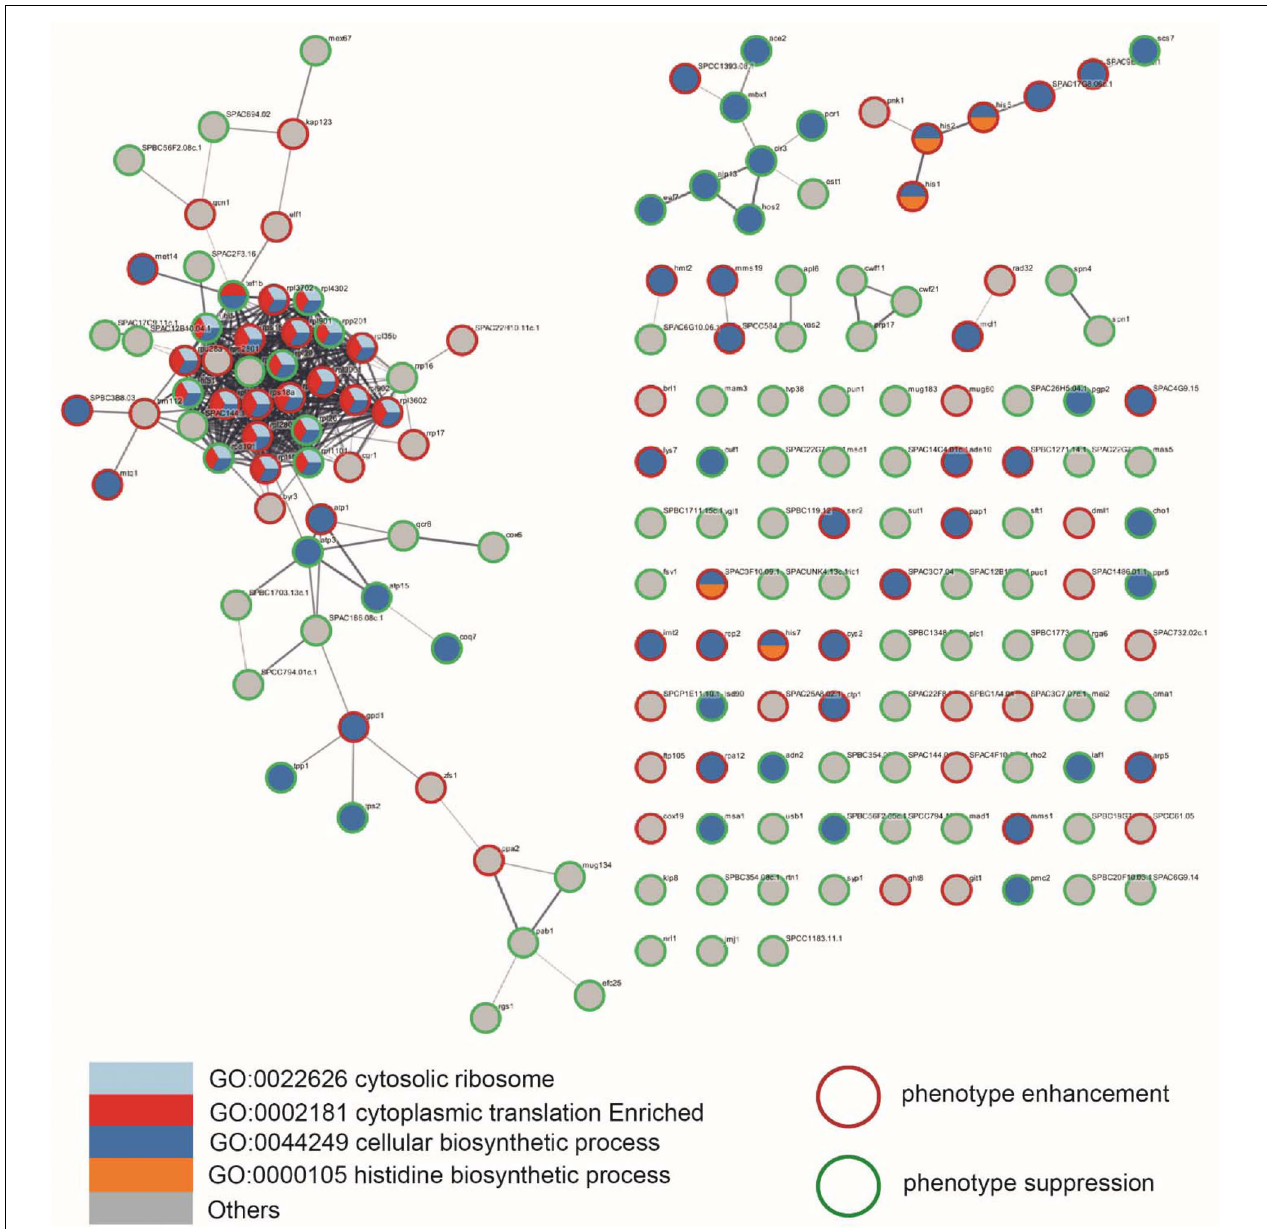
FIGURE 2 | Known protein–protein interactions (PPI) between products of genes that have genetic interactions with ate1 in S. pombe . The PPI database being utilized is Version 11 of STRING (https://string-db.org). The interaction map was generated with Cytoscape using the STRING App for creating the PPI information and enrichment mapping. The thickness of the connecting line represents the confidence of the experimental protein-protein interaction. A thicker line represents a higher confidence (a minimum of 0.4% confidence was used). Each rounded shape represent the product of a gene (with gene name labeled on the side). The assigned color of the rounded shape represents gene category (by GO terms), while the color of the ring (red or green) represent the direction of the genetic interaction (phenotype enhancing or